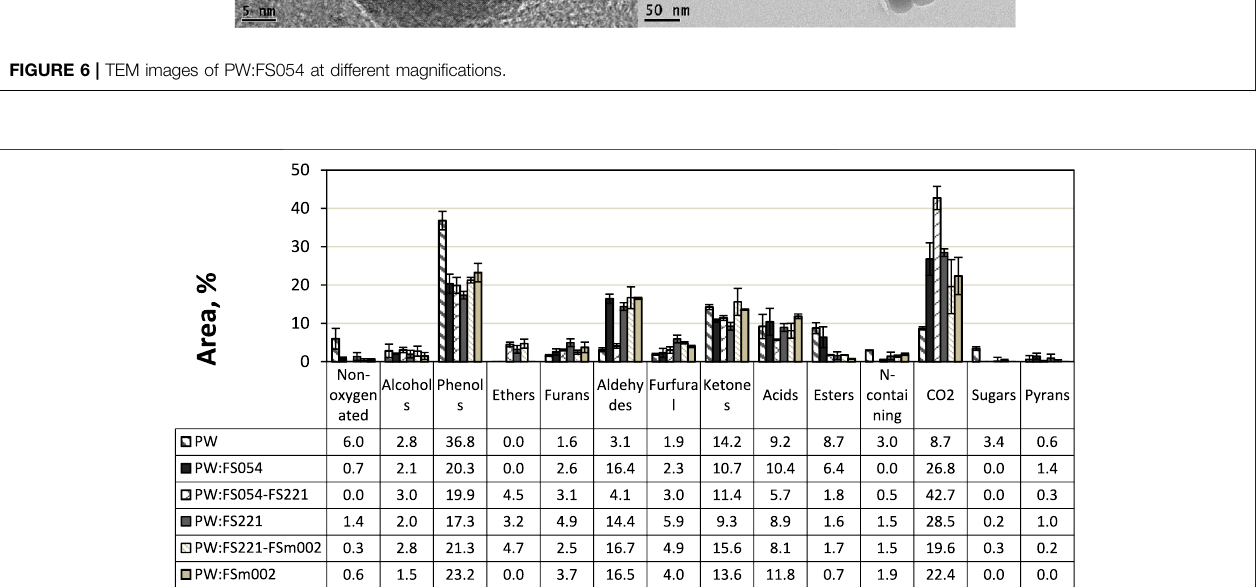
FIGURE 7 | Effect of α -Fe 2 O 3 size on the PW CFP products